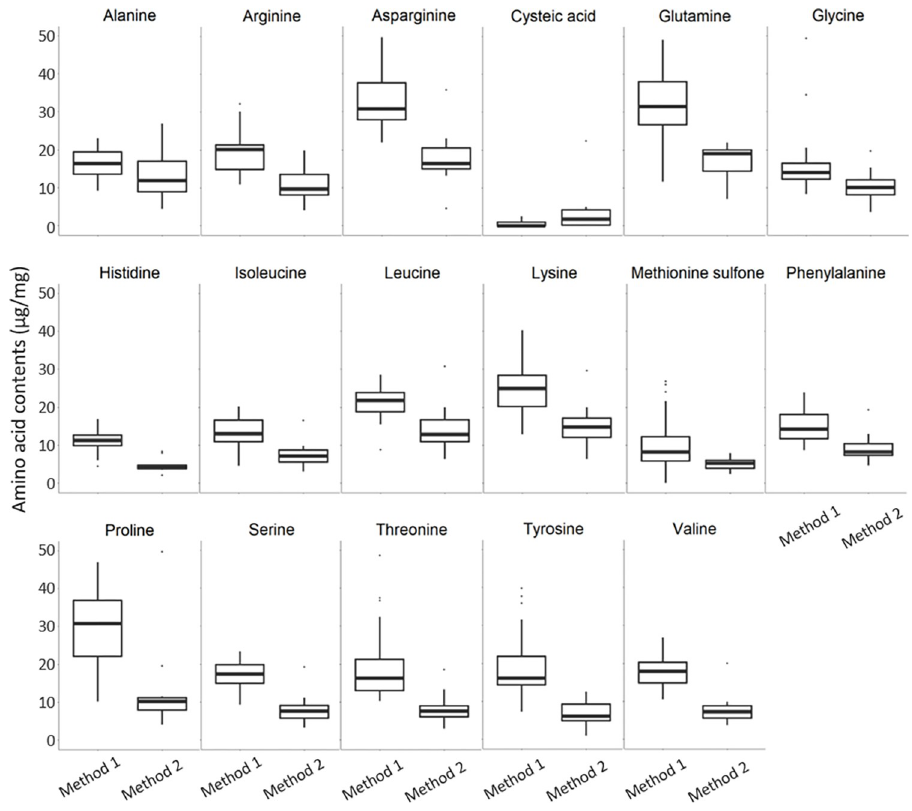
Fig 3. Boxplots of the contents of each amino acid ( μ g/mg) according to the IEX chromatography method (Method 1) and the HPLC method (Method 2).